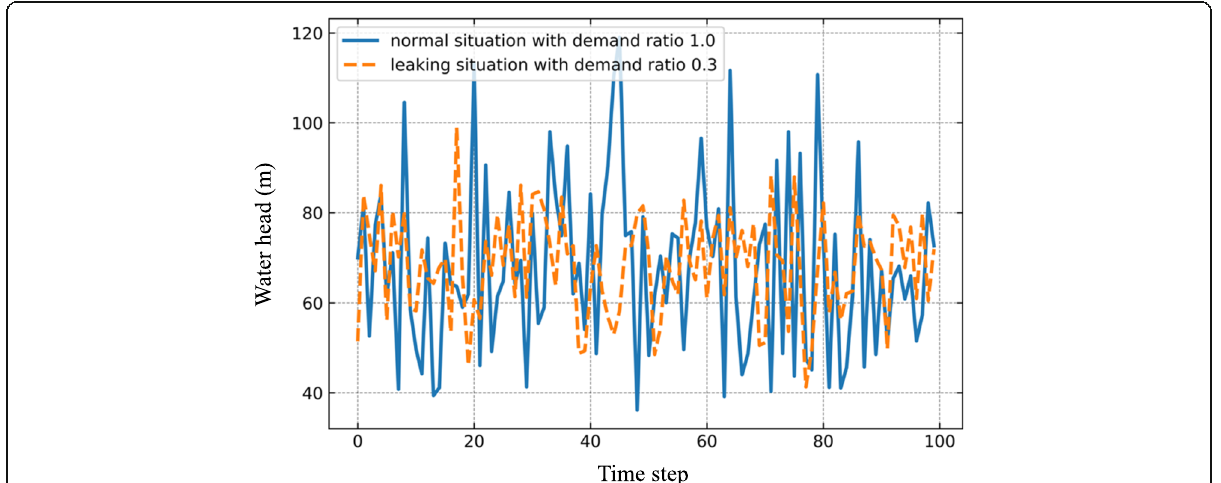
Fig. 6 Illustration of water head at node ‘ 168 ’ : the average water head is similar for non-leaking condition with high water demand versus leaking condition with low water demand